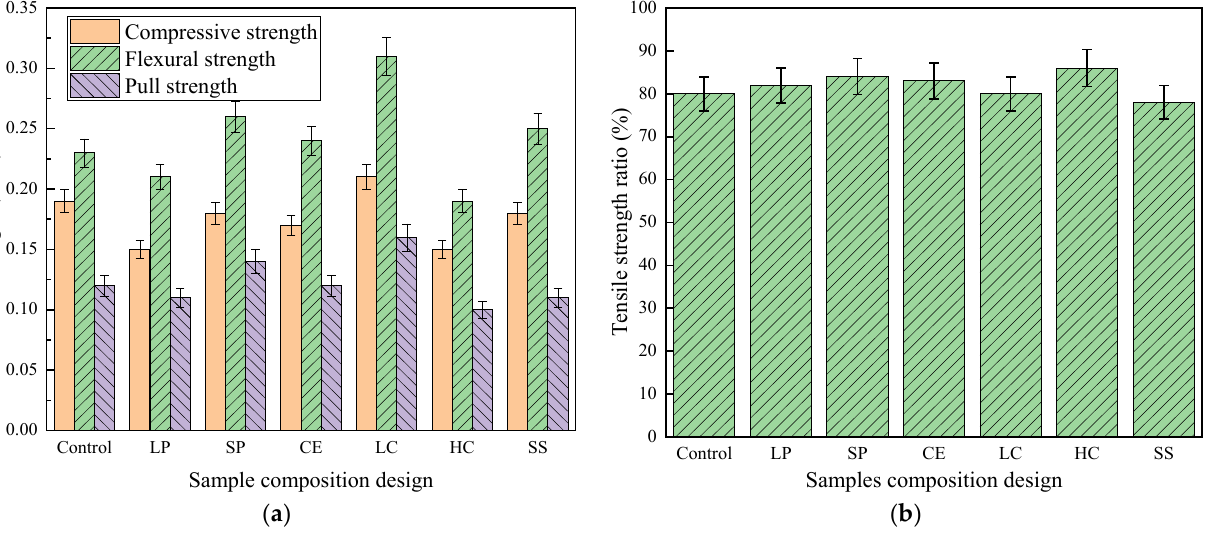
Figure 5. The strength and residual tensile strength ratio of seven CEPS groups: ( a ) strength and ( b ) tensile strength ratio.